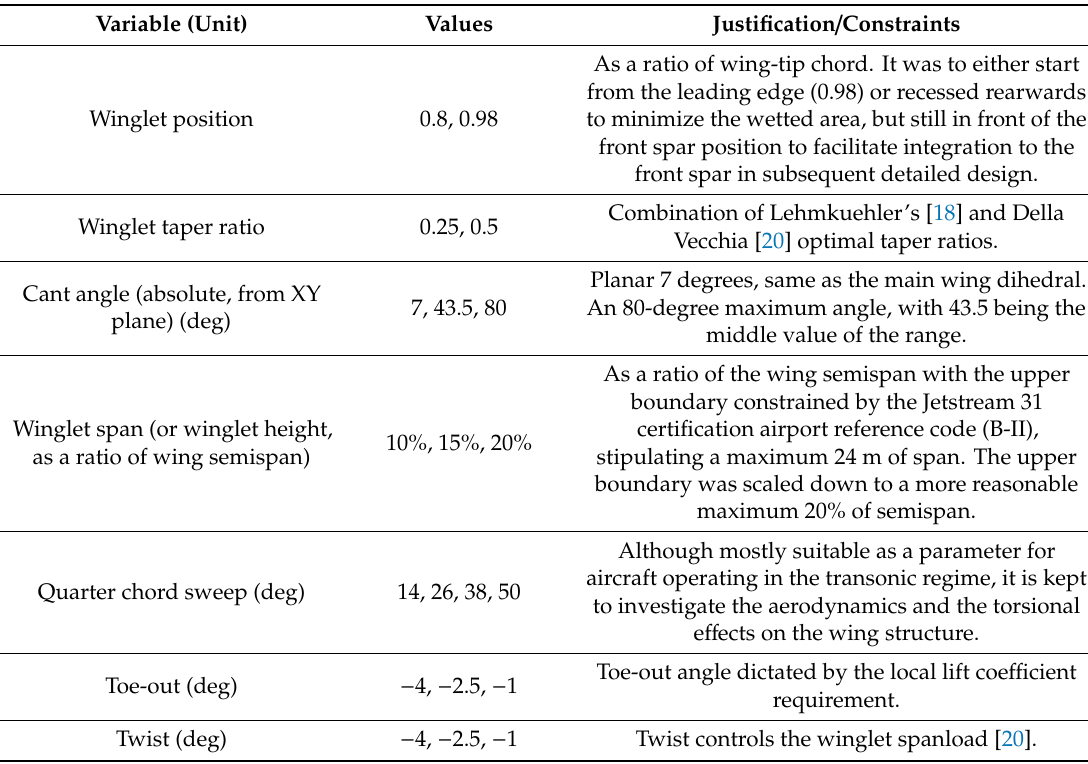
Table 2. Design variables and evaluated values (1296 design